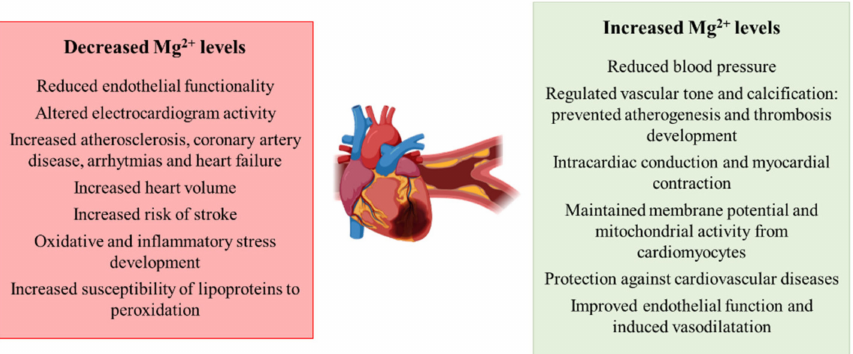
Figure 4. Schematic representation of the contribution of decreased and increased magnesium levels to the development of hypertension and cardiovascular